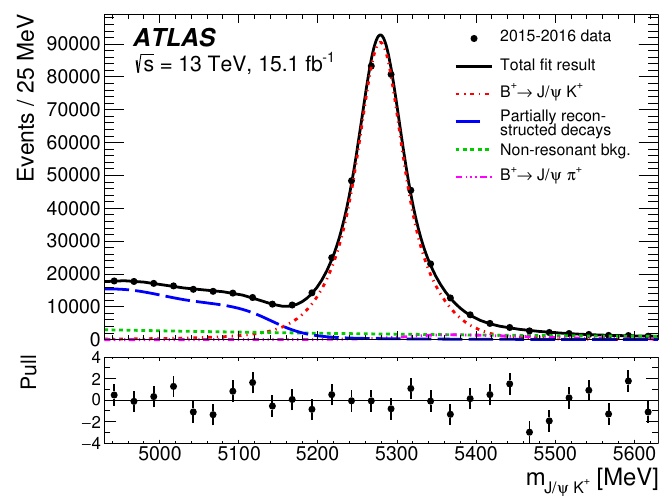
Figure 5. Result of the (cid:12)t to the J= K + invariant mass distribution for all B + candidates in half of the data events. The various components of the spectrum are described in the text. The inset at the bottom of the plot shows the bin-by-bin pulls for the (cid:12)t, where the pull is de(cid:12)ned as the di(cid:11)erence between the data point and the value obtained from the (cid:12)t function, divided by the error from the